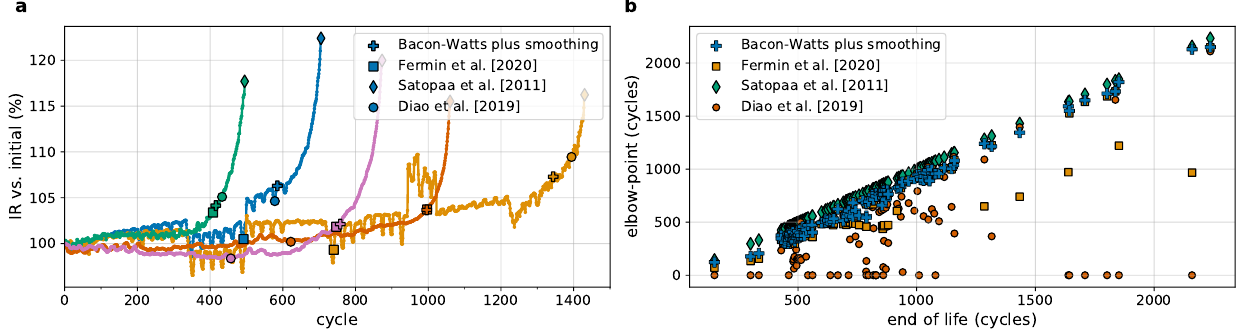
Figure 5. ( a ), Comparison of elbow-points obtained with Algorithm 1, [19]’s Bacon–Watts, maximum curvature and slope changing ratio methods on a sample of cells from the A123 dataset (from left to right b2c34, b1c30, b3c15, b3c1, b1c3). ( b ), Comparison of elbow-points for all cells in the A123 dataset. One expects to see a linear relationship between EOL and elbow-point; of the methods compared only Algorithm 1 and the algorithm of Satopaa et al. [2011] recover a linear relationship reliably, however, by examining plot ( a ), we see that Satopaa’s algorithm selects the end point as the